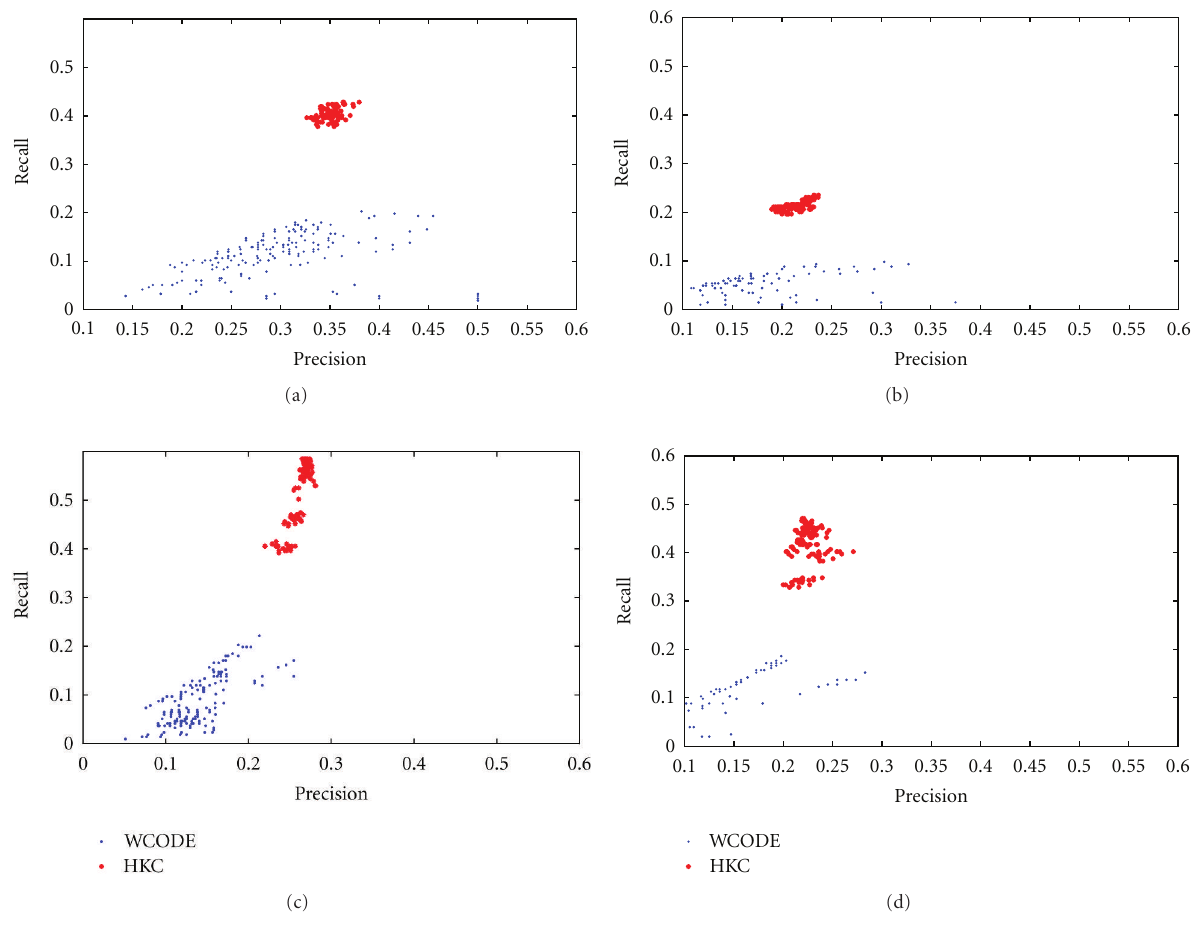
Figure 5: Precision versus Recall plots of all WCODE and HKC results with di ff erent parameters on various data sets. (a) Input data set: MIPS, benchmark: complexcat. (b) Input data set: MIPS, benchmark: Gavin. (c) Input data set: SGD-MC, benchmark: complexcat. (d) Input data set: SGD-MC, benchmark: Gavin. For all four cases, the data points resulted by HKC are located in the upper right portion of the plot, corresponding to high values of F-measure, while most of the data points resulted by MCODE are located in the lower left part of the plot. Furthermore, the data points resulted by HKC are much more centralized than